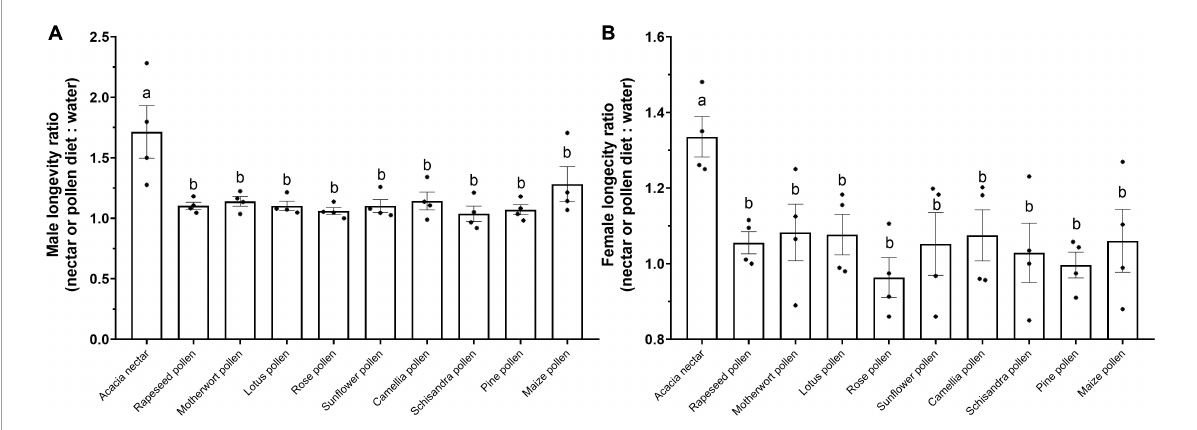
FIGURE3 Mean ( ± SE) male (A) and female (B) longevity ratio of noctuid moths on different nectar or pollen diets. Asterisks for each diet indicate actual ratios for each species of noctuid moths. Different lowercase letters on the top of bar indicates a significant difference in ratios (one-way ANOVA, Duncan’s MRT; p <